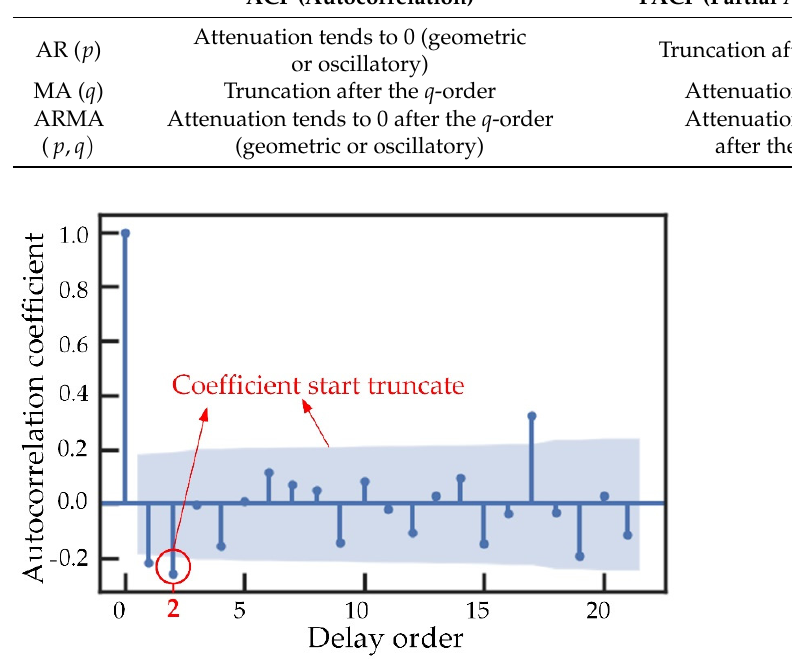
Figure 7. The autocorrelation comparison of the original sequence and the difference sequence.